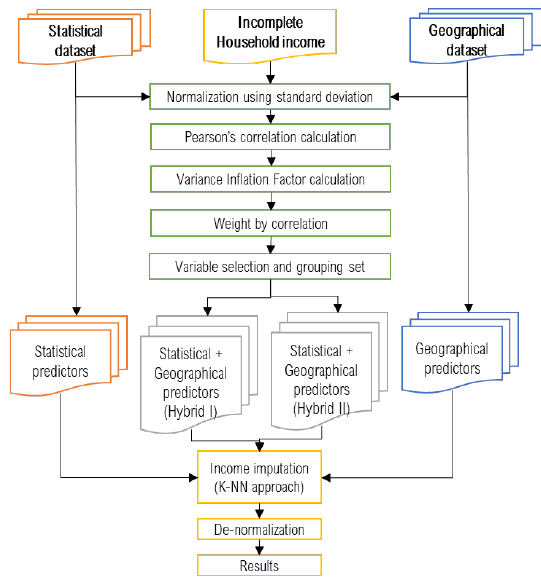
Figure 2. Household income imputation flowchart